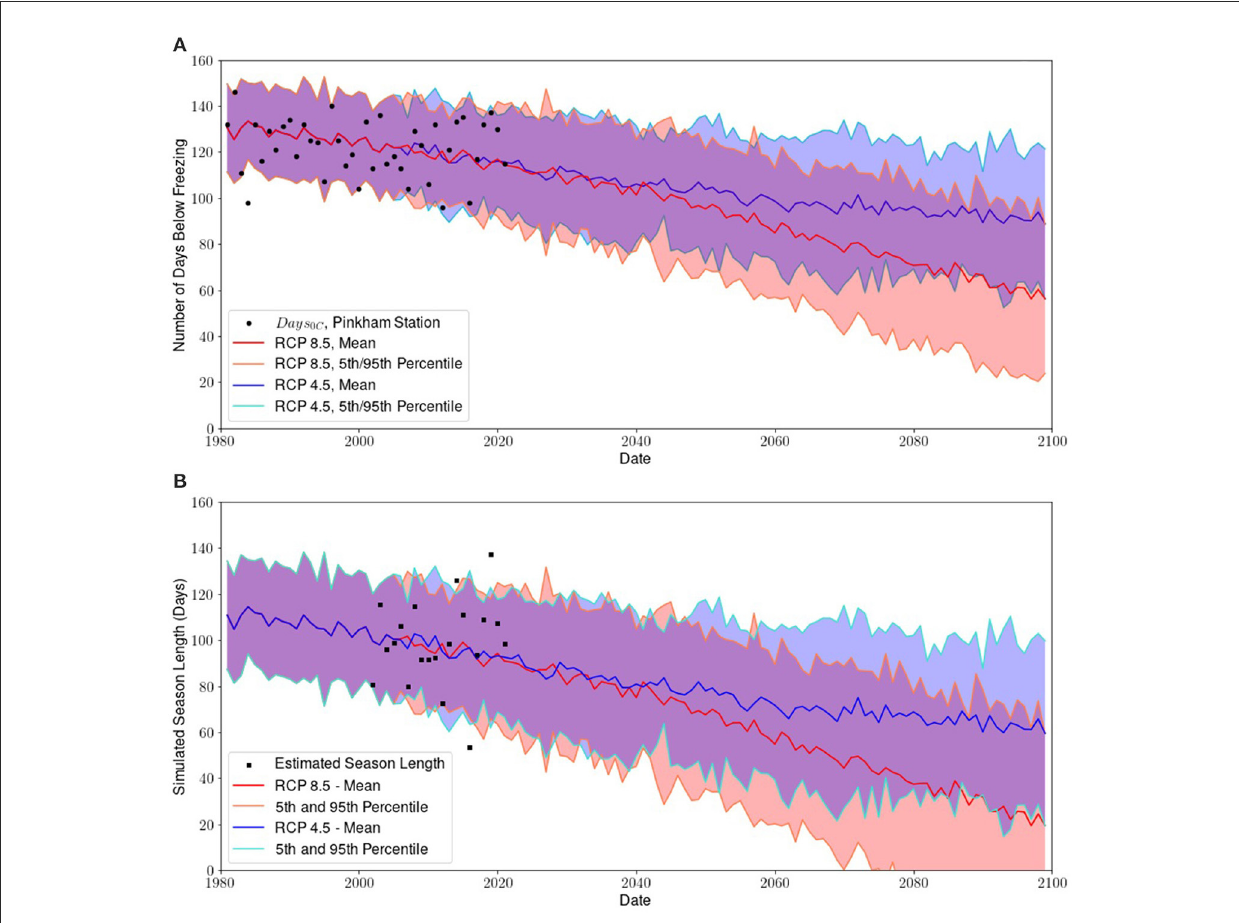
FIGURE5 The results of climate modeling. (A) Simulation of Days 0 C at Pinkham Station under RCPs 4.5 and 8.5, with historical Days 0 C superimposed. (B) Simulation of season length at Pinkham Station under RCPs 4.5 and 8.5, with historical season length estimates superimposed. Simulation was conducted by transforming Days 0C using the linear regression relationship between Days 0 C and estimated season length outlined in Figure 4. Significant declines in average season length are expected under both scenarios.